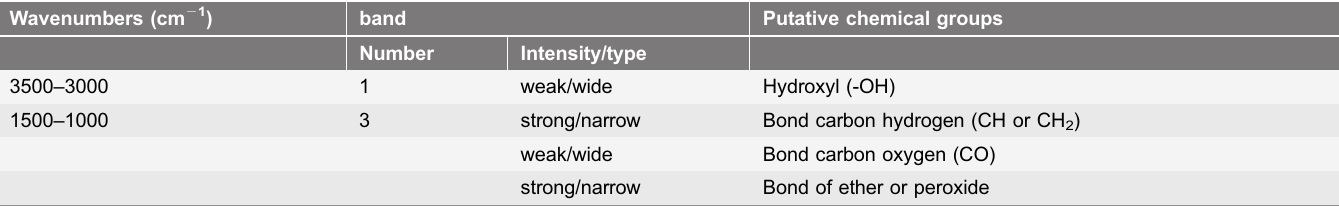
Table 3. Fourier transform infrared spectroscopy spectra of chemical alterations in oxo-biodegradable plastic after 30, 60 and 90 days of incubation with Pleurotus ostreatus . Wavenumbers (cm 2 1